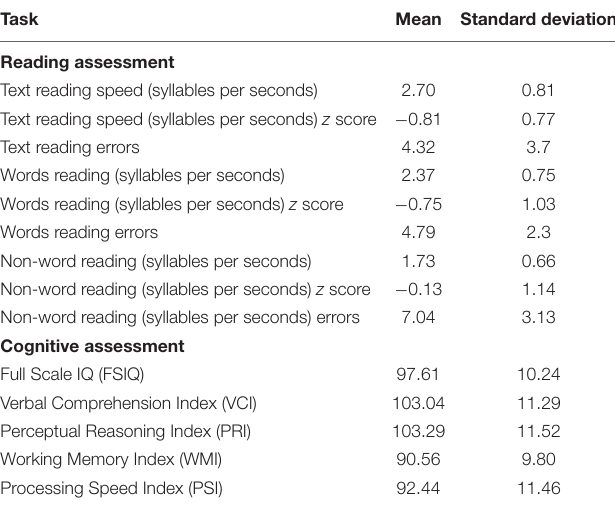
TABLE 2 | Main characteristics of the sample in terms of reading and cognitive abilities. Task Mean Standard